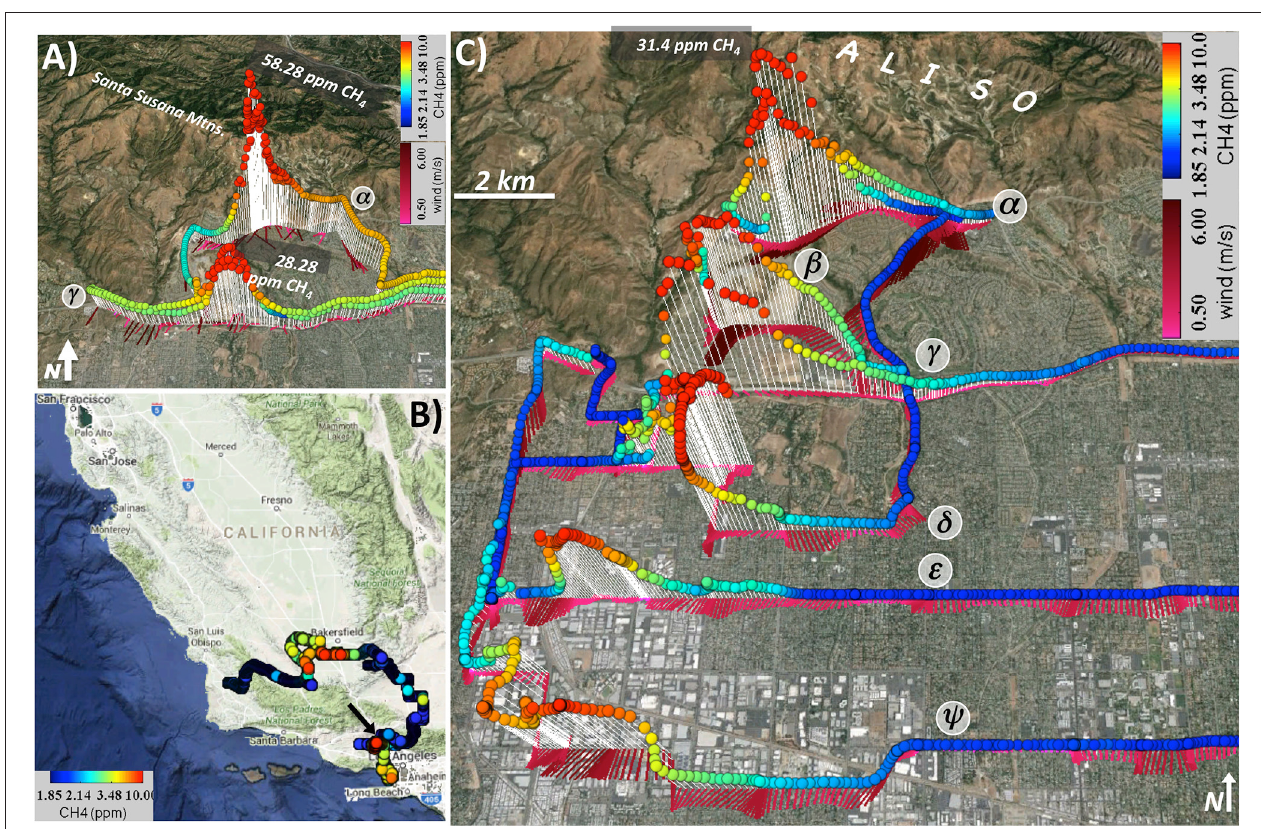
FIGURE 2 | (A) Pre-survey methane (CH 4 ) concentrations and winds downwind of the Aliso Canyon leak, collected 05:06–05:39 PST, 13 November 2015. Peak plume transect concentrations labeled. (B) California map showing all collected data 13–14 November 2015. Black arrow shows Aliso Canyon location. (C) Methane, CH 4 , and wind observations for the Aliso Canyon leak in the San Fernando Valley, CA, collected 10:40–15:10 PST, 13 November 2015. Note, CH 4 color bar is attenuated to capture spatial concentration structure near ambient. Data keys on